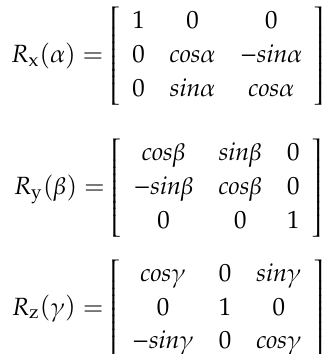
Figure 5. Schematic diagram of normal vectors p3 and p4 to plane of calibration ball spherical centers: ( a ) schematic diagram of normal vectors p3; ( b ) schematic diagram of normal vectors p4.